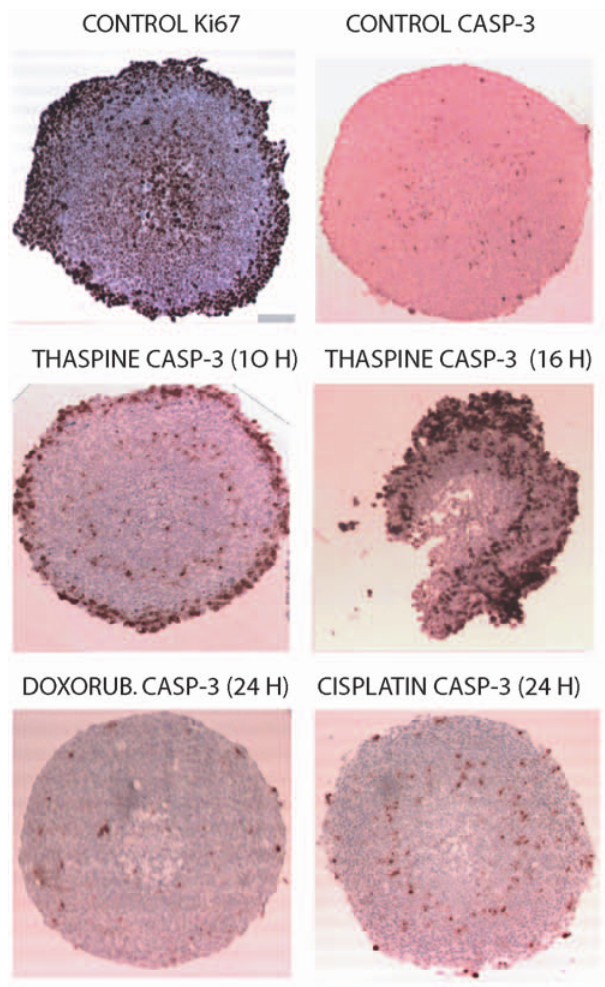
Figure 5. Thaspine induces wide-spread activation of caspase- 3 in spheroids. HCT116 spheroids with homogeneous diameters were formed using the hanging drop technique as described [40]. Five days after formation spheroids were compact and contained proliferating cells only in the surface layers (Ki67 staining, top left). Spheroids were treated with drugs for the times indicated, fixed, sectioned and stained for active caspase-3. Thaspine was used at 20 m M, doxorubicin at 20 m M, and cisplatin at 40 m